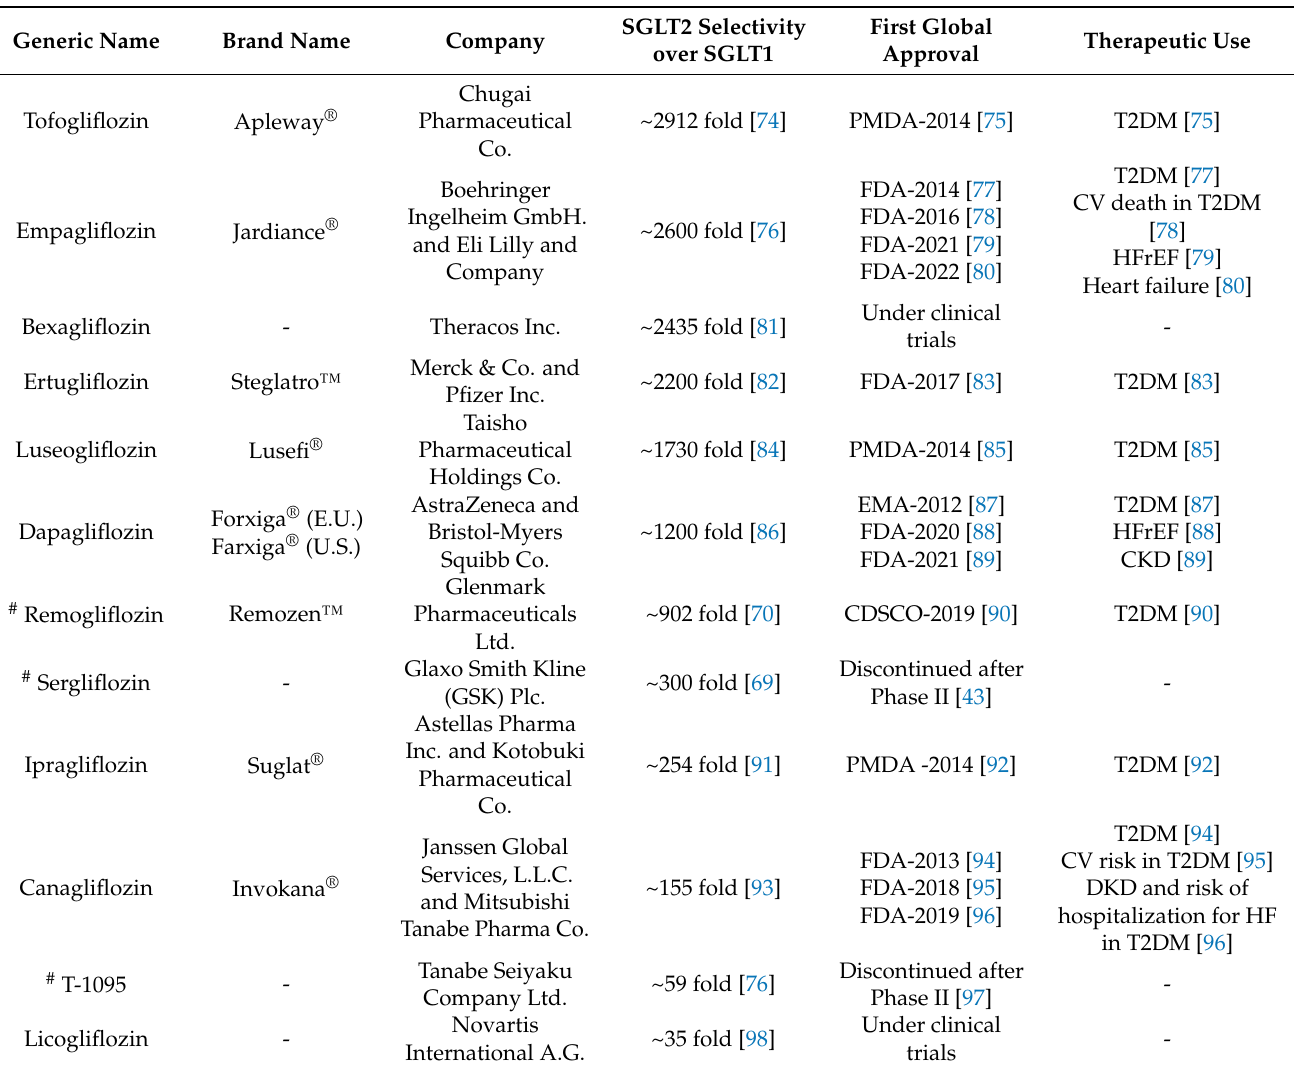
Table 3. Main SGLT2i developed, their human SGLT2/1 selectivity calculated by IC 50 (concentration causing half of the maximal inhibition) SGLT1/SGLT2 and first approved therapeutic